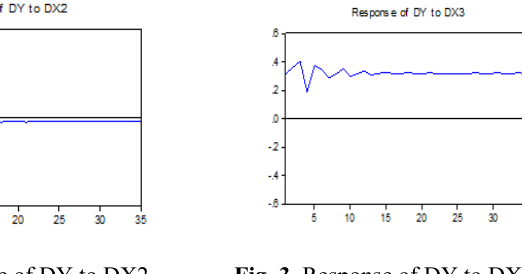
Fig. 1. Response of DY to DX1 Fig. 2. Response of DY to DX2 Fig. 3. Response of DY to